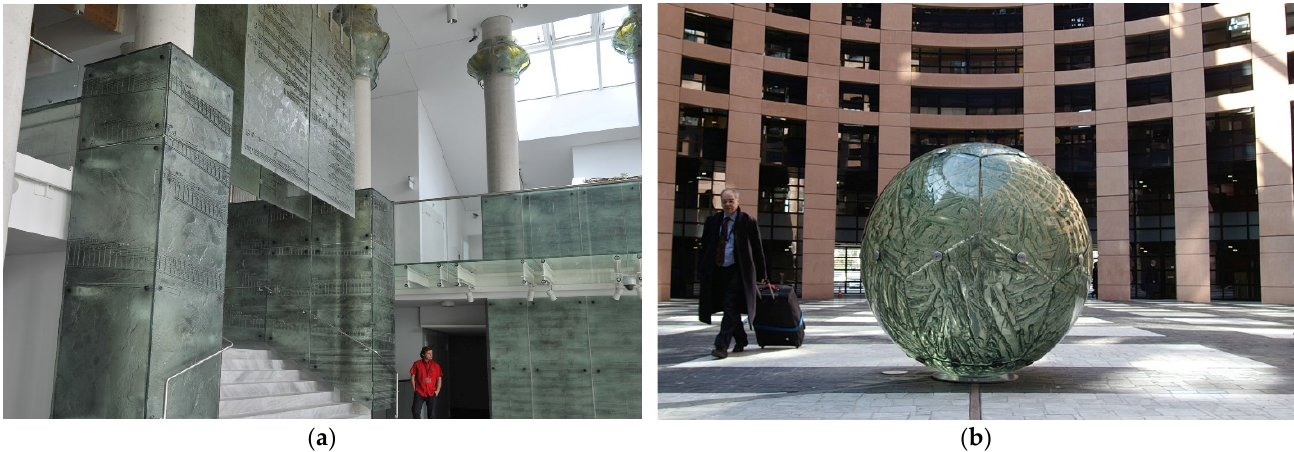
Figure 2. ( a ) Glass-art interior by Tomasz Urbanowicz at the Podlasie Opera and Philharmonic in Białystok, Poland, 2012; ( b ) United Earth glass sphere by Tomasz and Beata Urbanowicz in the European Parliament in Strasbourg, France, 2004 (Tomasz Urbanowicz).